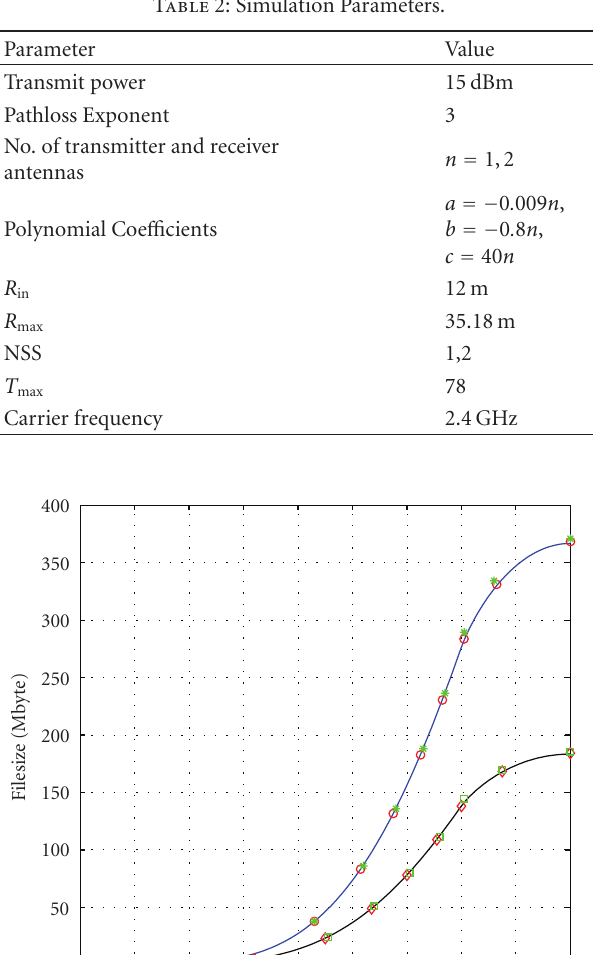
Table 2: Simulation Parameters.